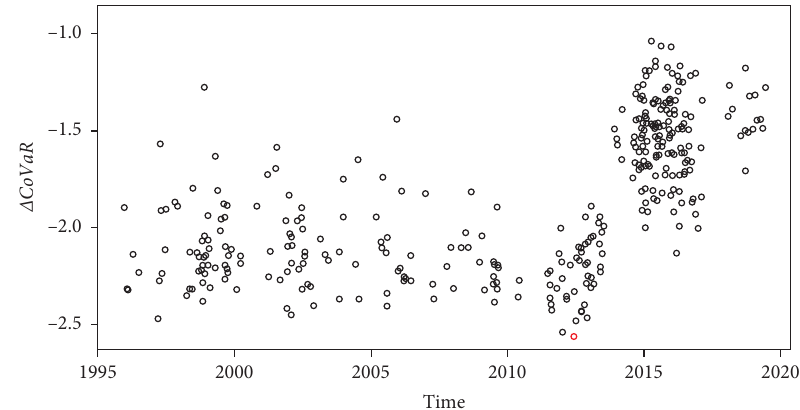
Figure 4: Scatter plot of ∆ CoVaR and time to market. Table 3: 10 stocks with the smallest CVaR values.